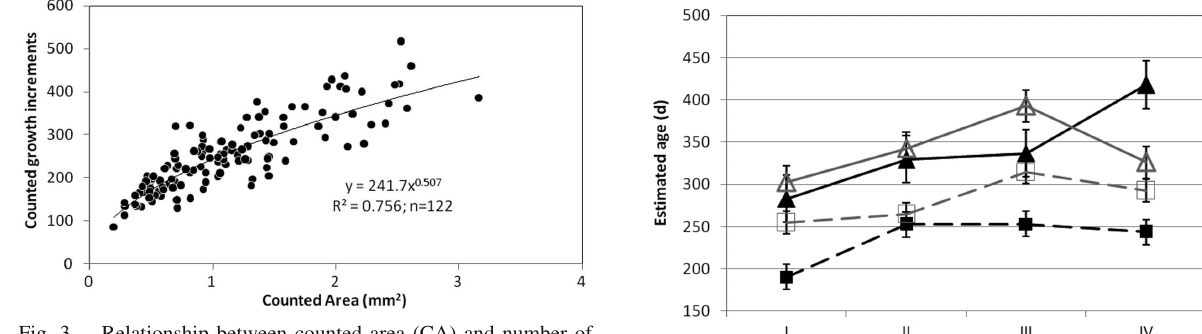
Fig. 3. – Relationship between counted area (CA) and number of counted growth increments in the stylet section of Eledone cirrhosa .